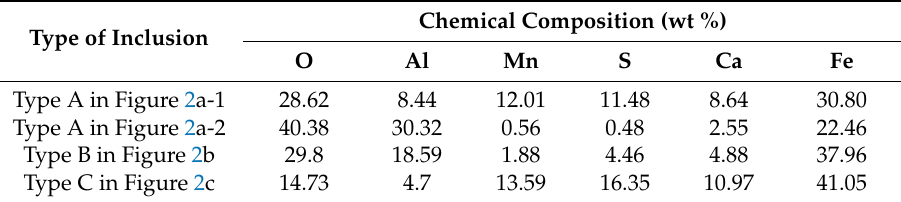
Table 3. Element percentages of the inclusions in Figure 2, obtained by EDS.